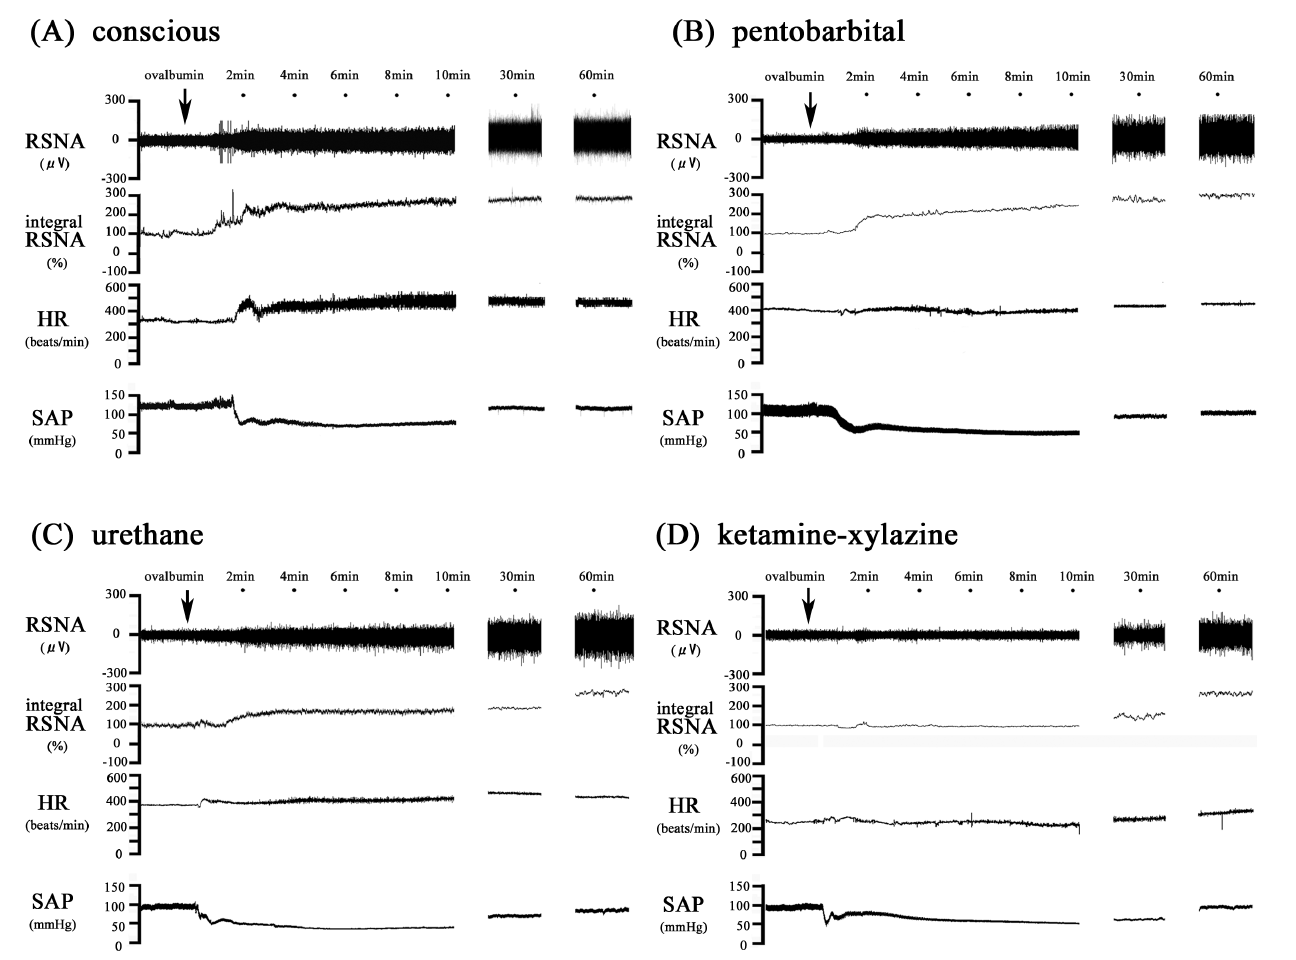
Figure 1. Sympathetic and hemodynamic responses to anaphylaxis in conscious and anesthetized rats. Representative recordings of RSNA, SAP and HR after an intravenous injection of the antigen, ovalbumin, into a sensitized conscious rat (A) and a sensitized rat under anesthesia with pentobarbital (B), urethane (C) or ketamine-xylazine